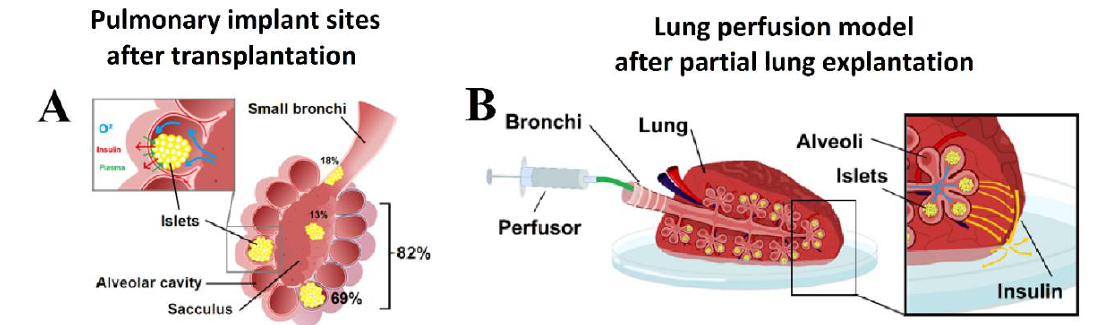
Figure 3. ( A ) Pulmonary transplant sites after AIT. Spatial distribution of islets at different locations in percent of total implanted Islets. ( B ) Pulmonary perfusion model for the detection of insulin production after transplantation. Continuous or pulsatile glucose stimulation can be achieved via alveolar exposure to glucose. The carrier volume (saline) of the glucose transports insulin through the lung tissue passing the visceral pleura where its concentration can be detected.